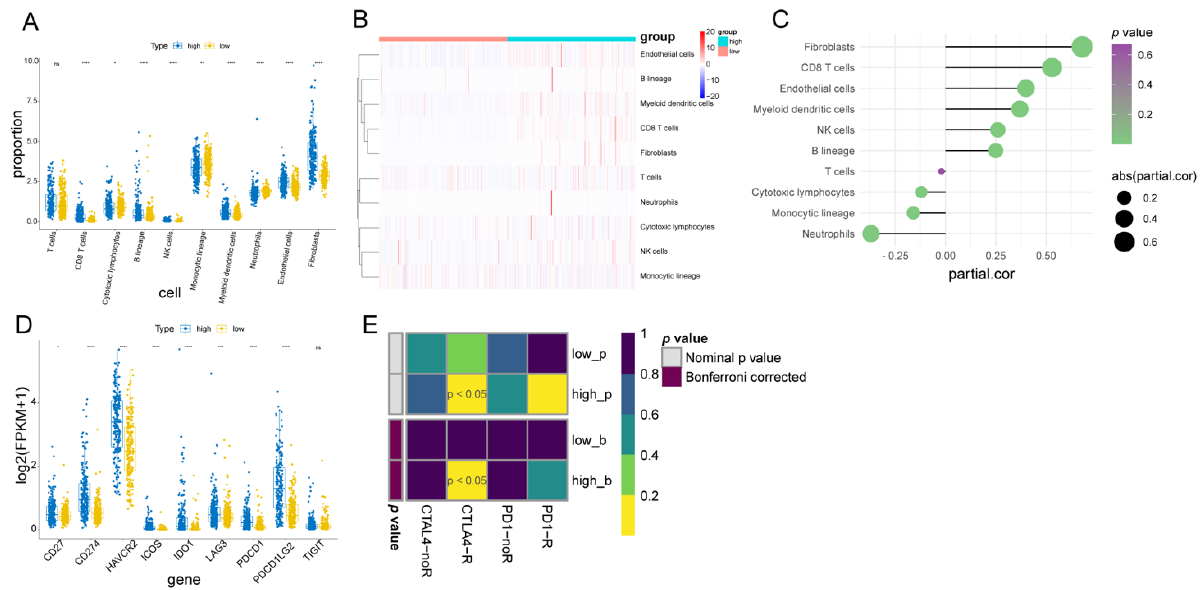
Figure 6. Tumor microenvironment and immunotherapy analysis of high- and low-risk groups: ( A ) box plot to show the difference in immune cells and stromal cells between the high- and low-risk groups; ( B ) heatmap of cell contents calculated using MCP-counter; ( C ) lollipop chart to show the correlation between risk score and immune cells and stromal cells; ( D ) box plot of immune checkpoints in high- and low-risk groups; and ( E ) SubMap algorithm result to predict the response probability of high- and low-risk groups to immunotherapy.